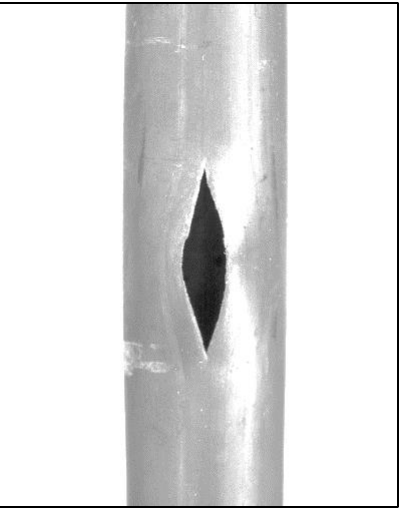
Figure 8. Rupture failure of axially oriented corrosion defect [66].